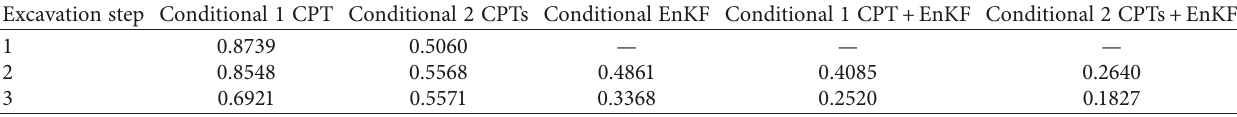
in X displacements. d